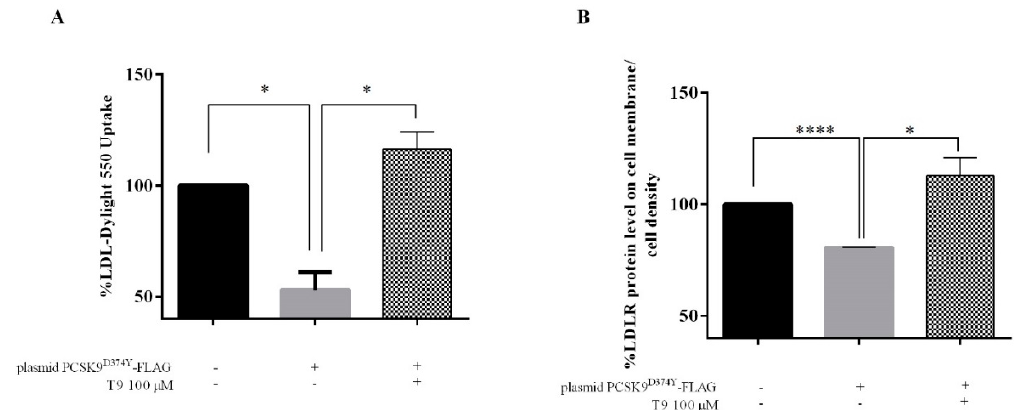
Figure 4. ( A ) Fluorescent LDL-uptake assay after treatment of HepG2 with T9. HepG2 cells were transfected and subsequently incubated with T9 for 24 h. Then, the specific fluorescent LDL uptake was measured by the Synergy H1 fluorescent plate reader. Data points represent averages ± S.D. of three independent experiments in triplicate; (*) p < 0.05. ( B ) Cell surface LDLR levels in HepG2 cells. An ICW is a colorimetric cell-based assay where cell membranes are not permeabilized, useful to detect the up-regulation of specific LDLR protein target on the cell surface. Bars represent averages ± S.D. of three independent experiments. (*) p < 0.05 and (****) p <